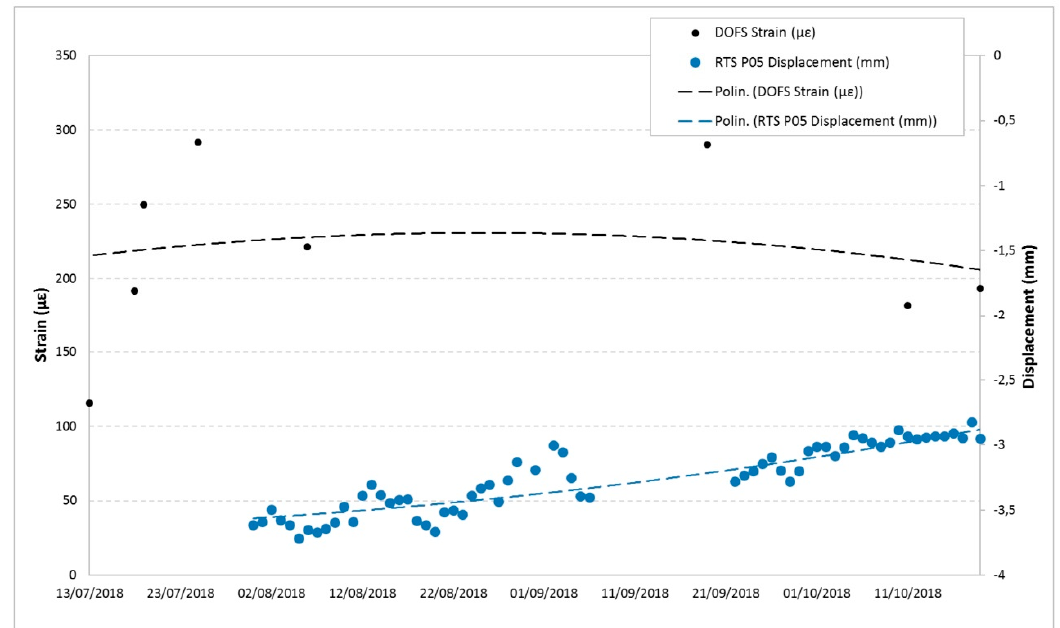
Figure 25. Comparison between the P05 RTS measuring point displacement (data interpreted according to a second order polynomial) and DOFS strain values in the same area.